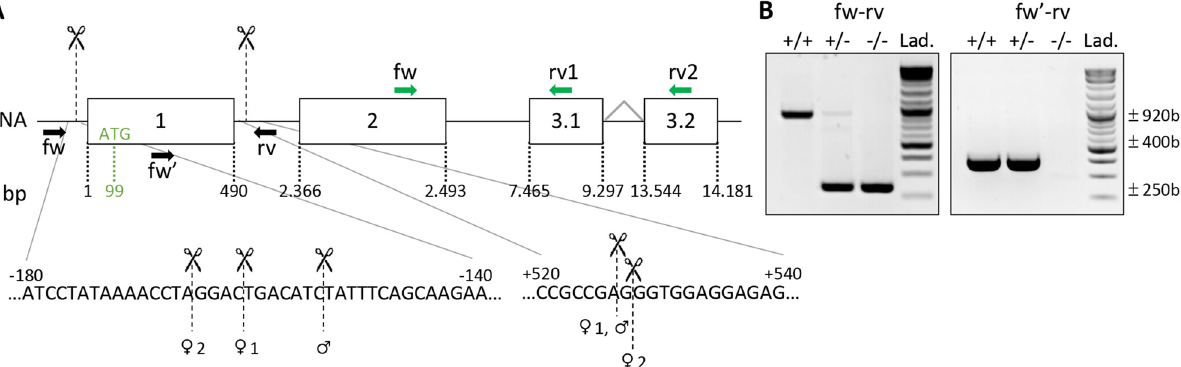
Figure 2. CRISPR/Cas9-based editing of MarvelD3 gene. ( A ) Schematic representation of the MarvelD3 locus. The MarvelD3 gene comprises four exons (boxes), the two first are common while either exon 3.1 or 3.2 are alternatively spliced to generate the two isoforms (MD3.1 and MD3.2). Numbers below the boxes indicate the position of the exons limits with respect to the transcription initiation site (+ 1). Position of the ATG (99 bases downstream of the + 1) in the first exon is also indicated. Scissors and the vertical dashed lines indicate the approximate region where the cuts occurred. Precise localization of the cuts is provided below for the three individuals used to derive the colony. Localisation of genotyping primers are represented by black arrows (fw- rv and fw ′ -rv); primers to assess MarvelD3 expression by RT-qPCR are shown in green (fw-rv1 = MD3.1 and fw-rv2 = MD3.2 ). ( B ) Illustrative genotyping results for wild-type (+ / +), heterozygous (+ /−) and knockout (−/−) mice, obtained with two sets of primers. Primers fw-rv, located outside of the targeted region (exon 1), can generate PCR products of ± 920 bp (wild-type allele: +), and ± 250 bp (deleted allele: -). Primers fw ′ -rv will only amplify a band of ± 400 bp on the wild-type allele (+ / + and + /−). Lad., DNA Generation and validation of a CRISPR‑Cas9 MarvelD3 knockout mouse. Knock-down of Mar- velD3 in Xenopus laevis embryos results in developmental defects of ectodermal derivatives 16,17 . In mice, we also detected MarvelD3 mRNA in tissues of ectodermal origin (Figure S2), but it was predominantly observed in endoderm-derived epithelial organs such as the pancreas. To study the in vivo role of MarvelD3 in the pancreas, we generated a MarvelD3 −/− model using a CRISPR-Cas9 gene editing system with two guide RNAs (Fig. 2A). This allowed removal of a DNA fragment of approximately 685 bp, encompassing the transcription initiation site, the first exon and part of the first intron. Excision of this fragment, common to both MarvelD3 isoforms, was verified by PCR (Fig. 2B). Amplicons generated with primers located outside of the targeted regions (fw- rv), gave rise to a ± 920 bp band for the wild-type allele and a ± 250 bp band for the deleted allele (Fig. 2B, left). Amplification of the wild-type allele in heterozygous (+ /−) mice was weaker than in homozygous (+ / +). A second forward primer (fw ′ ), located within the first exon, was also used with the reverse primer (rv) (Fig. 2B, right). Amplification of a ± 400 bp band revealed the presence of at least one wild-type allele (in + / + and + /−), while in knockout mice (−/−) no amplification was possible as the forward primer (fw ′ ) was in the deleted region. Finally, Sanger sequencing of the ± 250 bp amplicons revealed that the extent of the deletion ranged from 679 to 691 bp in the three founders used to generate the colony (Fig. 2B). MarvelD3 is dispensable for normal pancreas development and morphology.